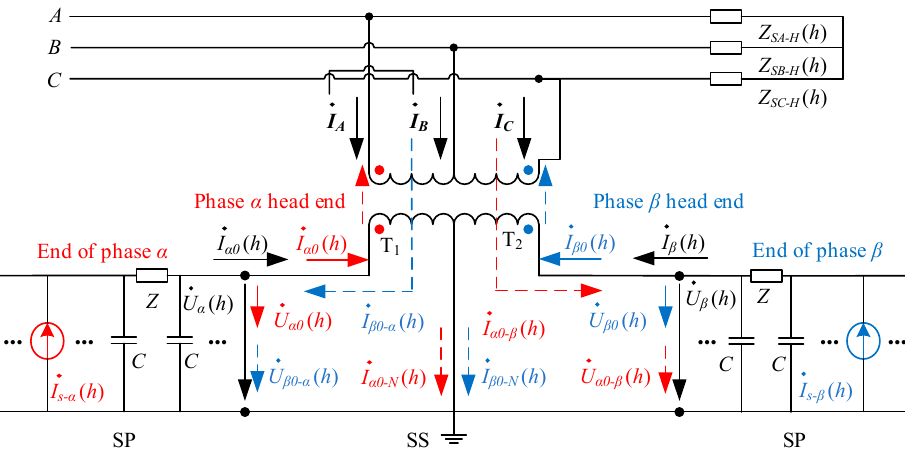
Figure 2. Transverse propagation path of high-order harmonics in a V/v connected traction trans- former.